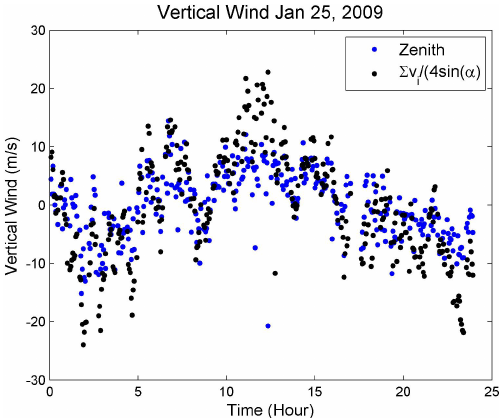
Fig. 10. Green-line vertical wind (ms − 1 ) 25 January 2009 as di- rectly observed (blue dots) and as calculated using the north, south, east and west winds (black dots) according to Eq.